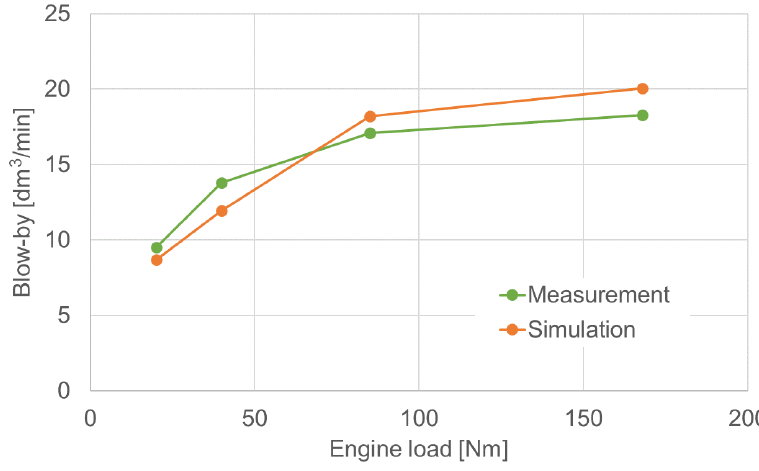
Figure 6. Simulated and measured blow-by rate.